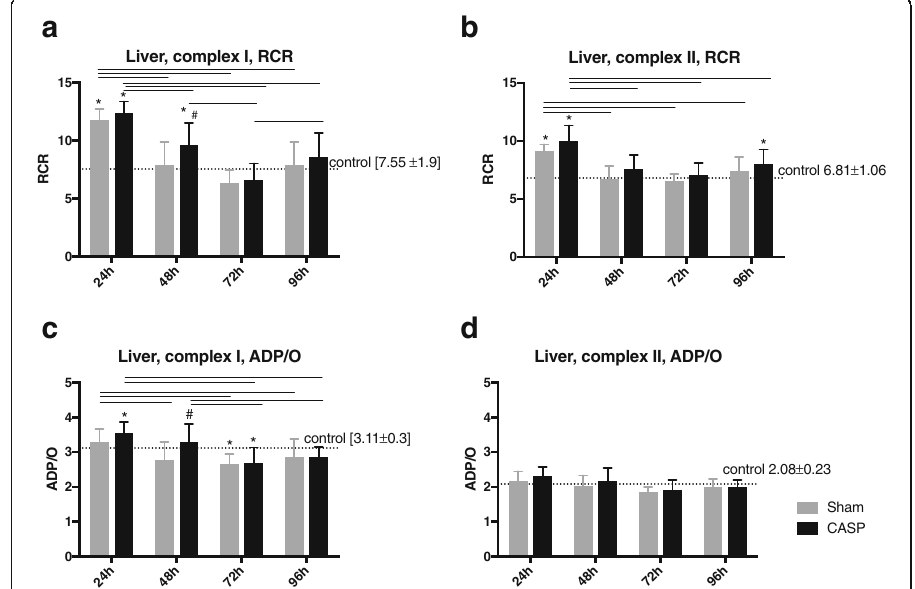
Fig. 3 The RCR (state 3/state 2) for complex I ( a ) and complex II ( b ) was measured in liver homogenates from each group (control, straight horizontal dotted line; sham-operated, light grey bars; CASP-operated, dark grey bars), in a time-dependent manner. The ADP/O ratio for complex I ( c ) and complex II ( d ) in liver homogenates of the same groups was also measured. * p < 0.05 vs. control, # p < 0.05 vs. sham, between groups, data are shown as mean ± SD (control n = 9, sham n = 12, CASP n = 11 – 12, the value for each animal was calculated as the mean of three technical